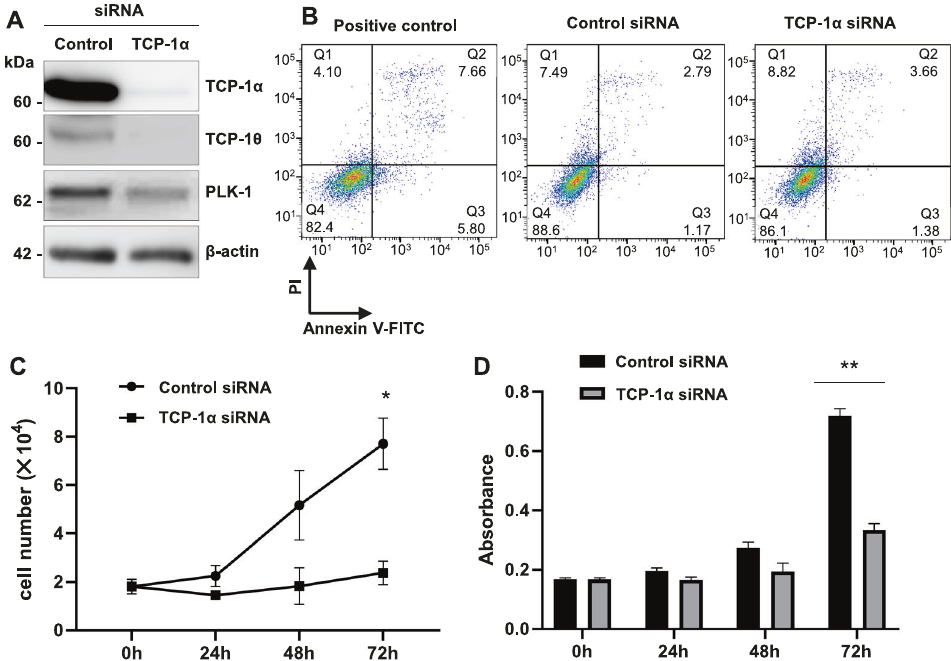
Fig. 4 Effects of inhibiting CCT function with siRNA against TCP-1 α in HGrC1 cells. A Relative protein expression levels were determined with a western blot assay. Transfection of TCP-1 α siRNA into HGrC1 cells reduced the expression of TCP-1 α ; TCP-1 θ , another subunit of CCT; and PLK1, a cell growth factor. β -Actin was used as the control. B Alteration in apoptosis of HGrC1 cells with TCP-1 α siRNA or control siRNA. Cells were stained with fl uorescein isothiocyanate (FITC)-conjugated annexin V and analyzed using fl ow cytometry. Positive control refers to the rate of apoptosis in HGrC1 cells cultured without serum for 72 h. C Analysis of the number of CuO-POTEF-Flag HGrC1 cells treated with TCP-1 α siRNA or control siRNA. Cells were counted every 24 h. D BrdU proliferation assay of CuO-POTEF-Flag HGrC1 cells with TCP-1 α siRNA or control siRNA. BrdU incorporation was measured using an ELISA system. Data are presented as means ± SD. Three independent experiments showed similar results. * P < 0.05 TCP-1 α siRNA vs control